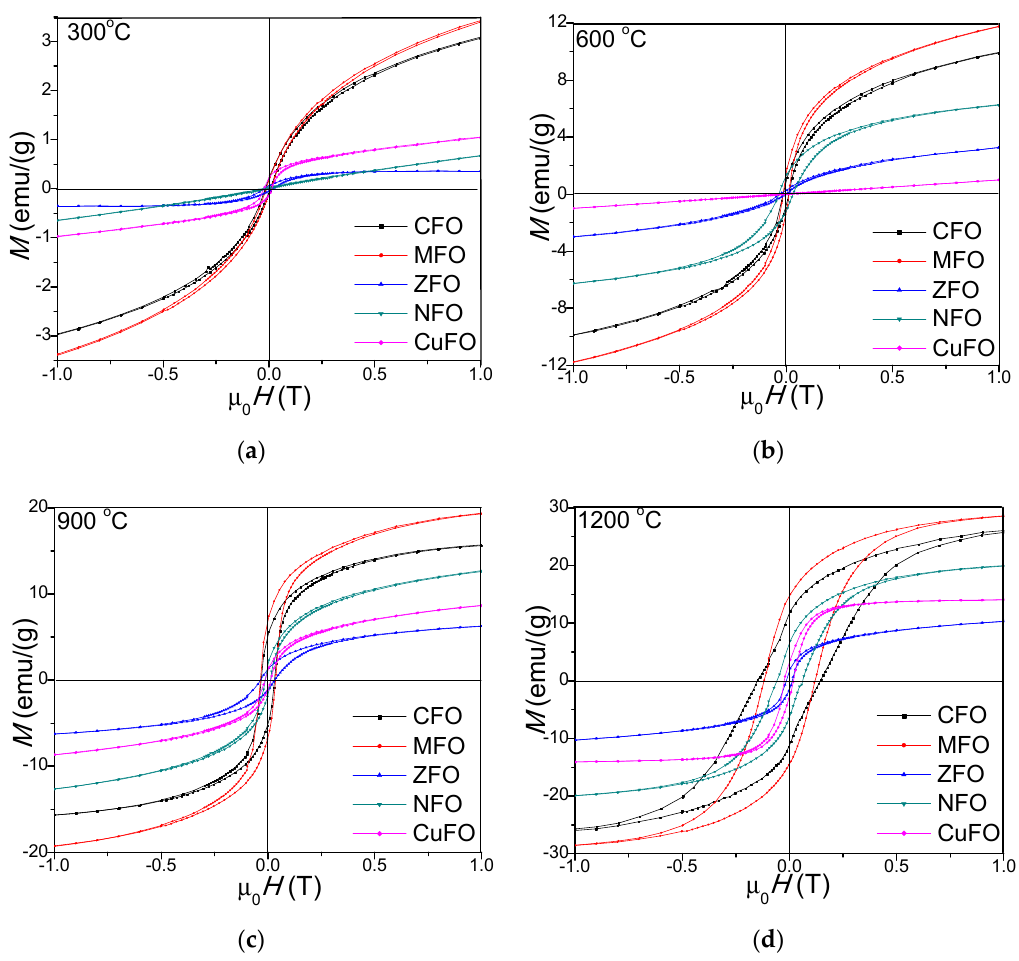
Figure 5. Magnetic hysteresis loops of CFO, MFO, ZFO, NFO, and CuFO NCs annealed at 300 ( a ), 600 ( b ), 900 ( c ), and 1200 °C ( d ).